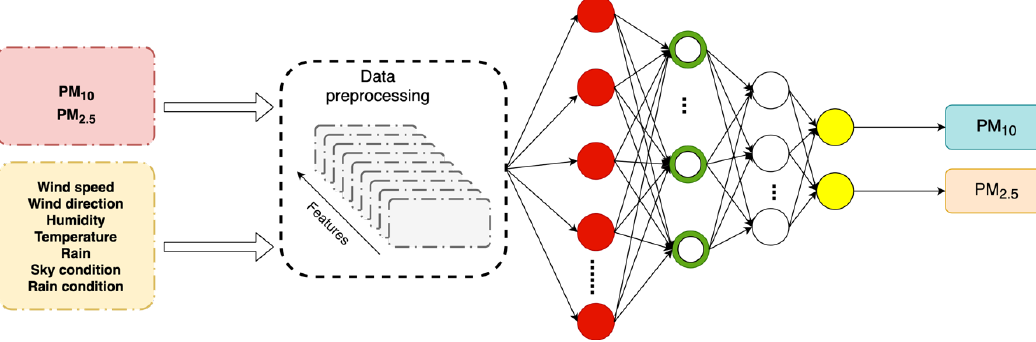
Figure 7. Training workflow for all models.